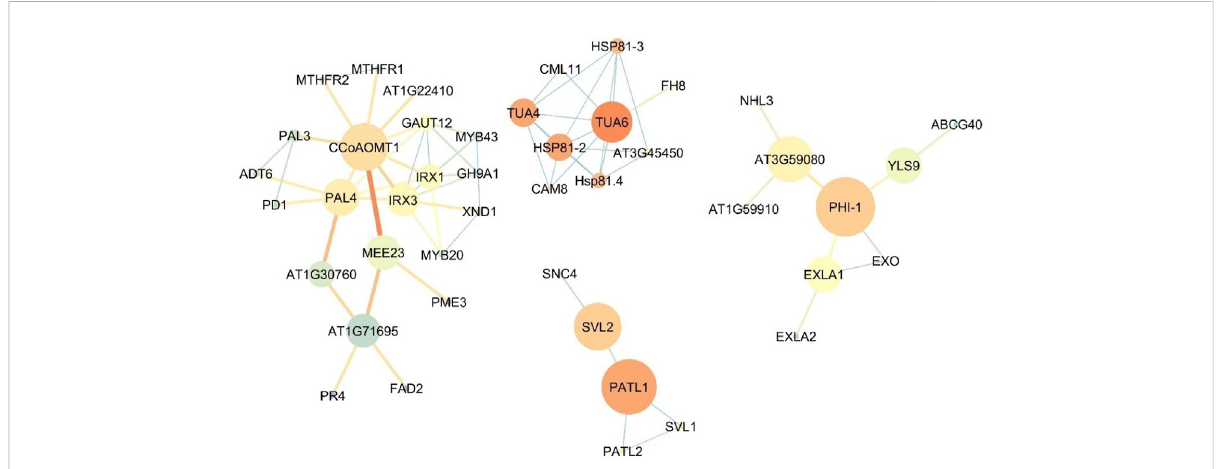
FIGURE 5 Theco-expressionnetworkofupregulatedgenesintherootof Oliveriadecumbens Vent.Thebiggersizeofthenodeisrepresentativeofhigher betweenness centrality and the darker the red color is representative the higher the Closeness centrality and blueish color showing the lower closeness centrality in the network. Also, the thicker connective line and more reddish represents the higher Edge Betweenness and thinner and tending to light blue color showing the lower edge